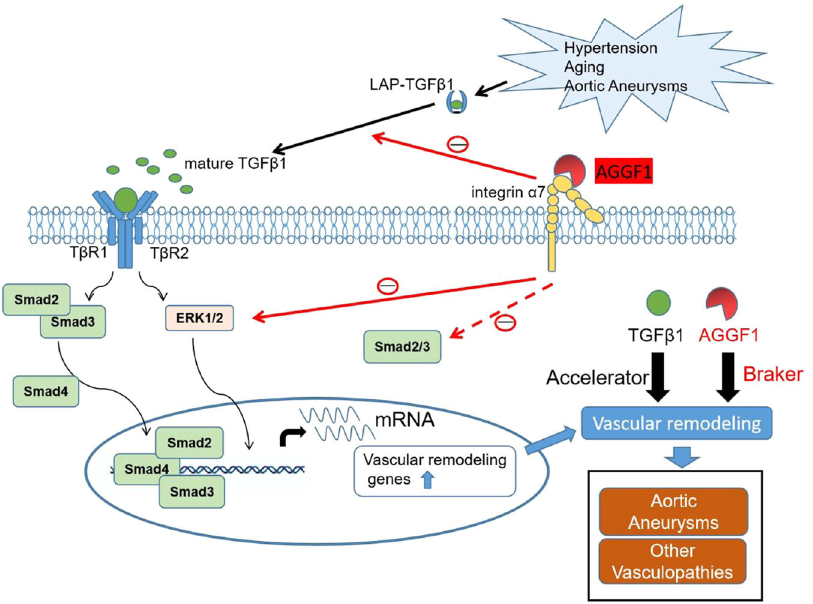
Fig. 10 | Molecular signaling pathways involved in vascular in fl ammation and remodeling. Pressure-overloadasincaseofhypertensioninducescleavageofLAP- TGF- β 1 and generation of mature TGF- β 1, activates Smad phosphorylation and ERK1/2 signaling, and results in transcription of genes involved in vascular in fl am- mation and remodeling. AGGF1 interacts with its receptor on VSMCs, integrin α 7, and enhances the interaction between integrin α 7 and TGF- β 1, which inhibits cleavage of LAP-TGF- β 1 and generation of mature TGF- β 1, reduces Smad phos- phorylation and ERK1/2 signaling, and results in reduced transcription of genes involved in vascular in fl ammation and remodeling, and attenuation